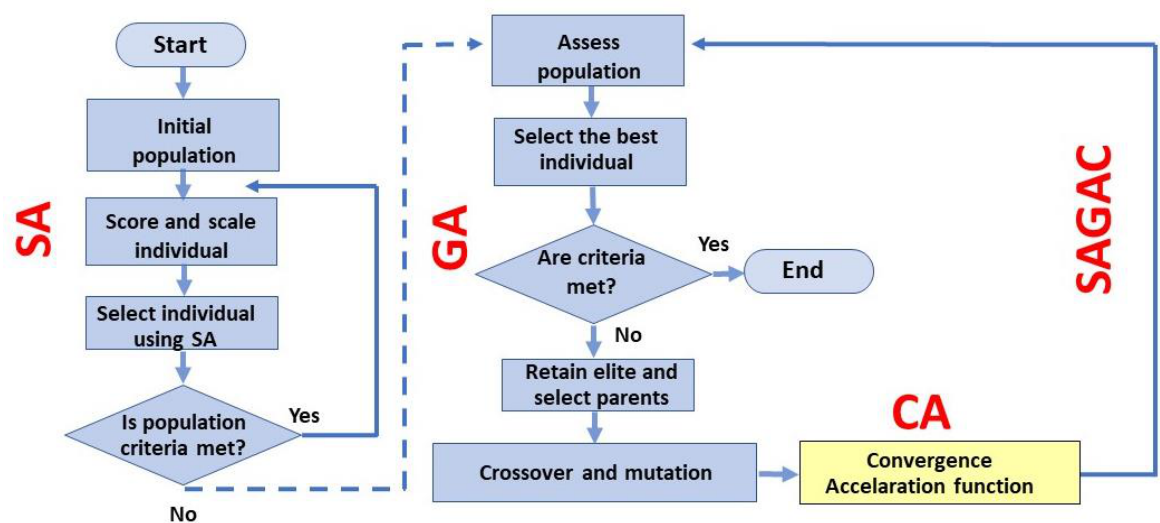
Figure 1. Flowchart of the hybrid SAGAC algorithm.